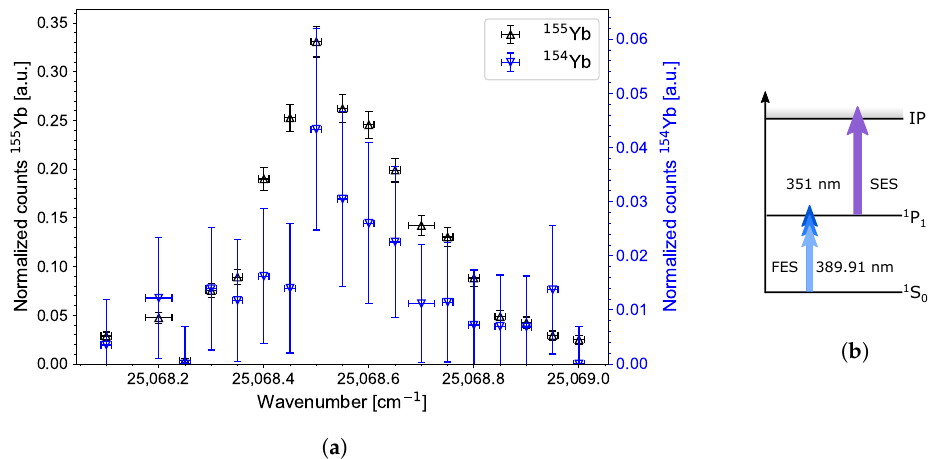
Figure 5. ( a ) Resonance ionization signal of 155 Yb (black) and 154 Yb ( blue). Both rates are normalized to their respective count rates for a direct transport of produced recoil nuclei per accumulated charge integral of the primary beam. ( b ) RIS scheme for laser spectroscopy of 154,155 Yb. The first excitation step was provided by a dye laser, the second, non-resonant step for ionization by a high-power excimer